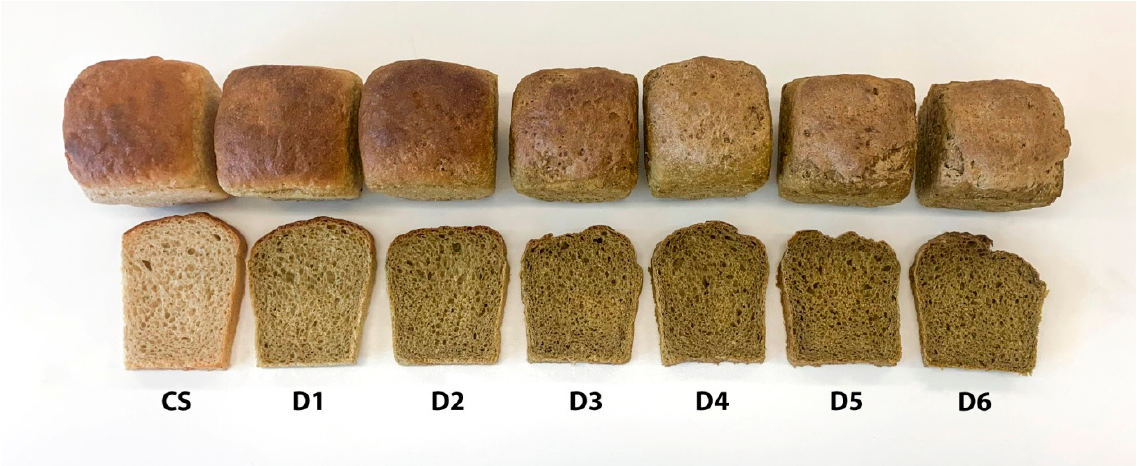
Figure 3. Picture of control and enriched bread samples. CS, D1, D2, D3, D4, D5, D6—control bread and bread with 1, 2, 3, 4, 5 and 6% of DF, respectively. Table 6. Sensory results of control and DF-enriched